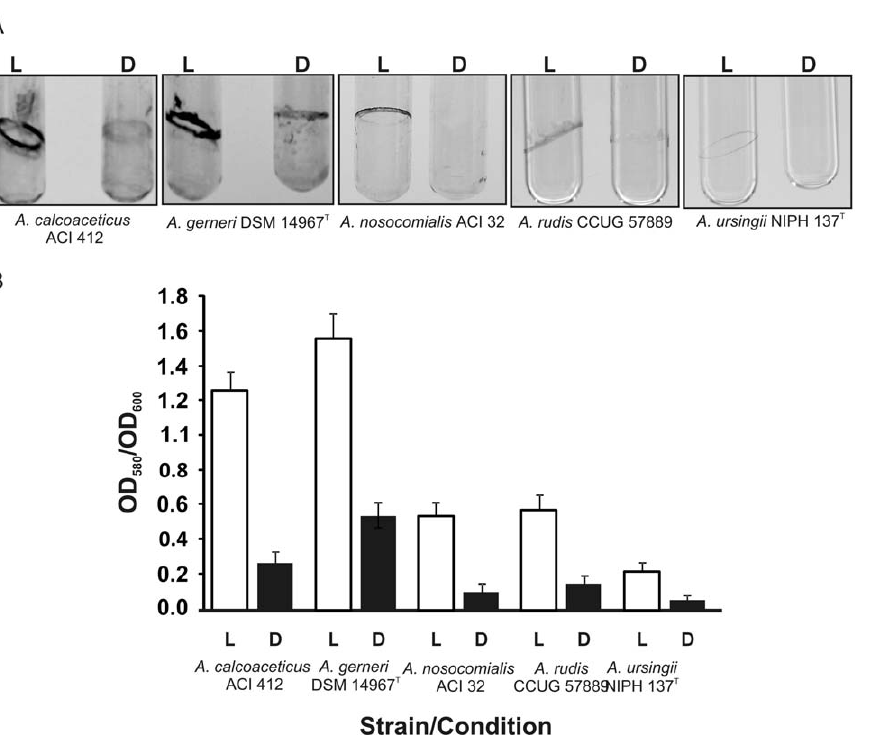
Figure 2. Effects of light on biofilm formation. A. The biofilms formed by cells of the different species within the genus Acinetobacter on glass tubes in the presence of blue light (L) or in darkness (D) were recorded after static incubation for 96 h at 24 u C by direct visual inspection and staining with crystal violet. Only representative examples are shown. B. Quantification of the biofilms of cognate samples shown in A. Error bars show standard error of the mean for 3 different biological replicates (n=3). OD 580 / 600 , optical density at 580 or 600 nm, respectively. L: light; D: Dark.